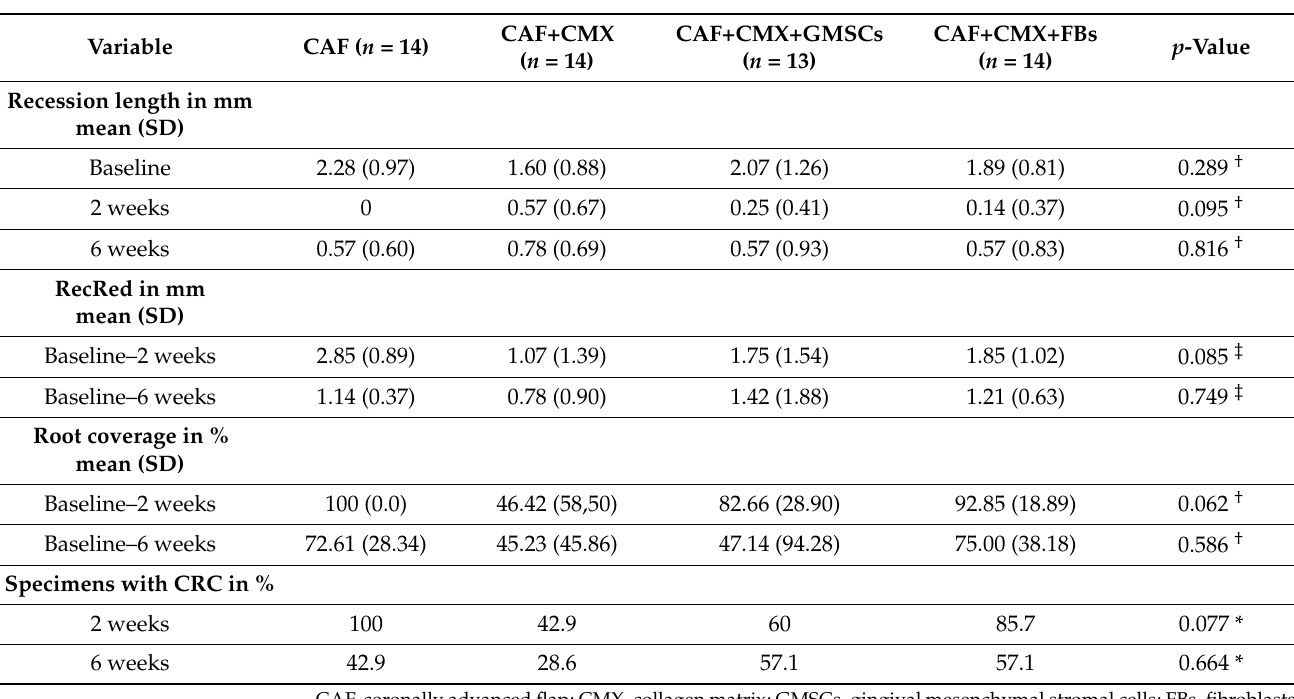
Table 2. Clinical variables at baseline and 2 and 6 weeks after the root coverage